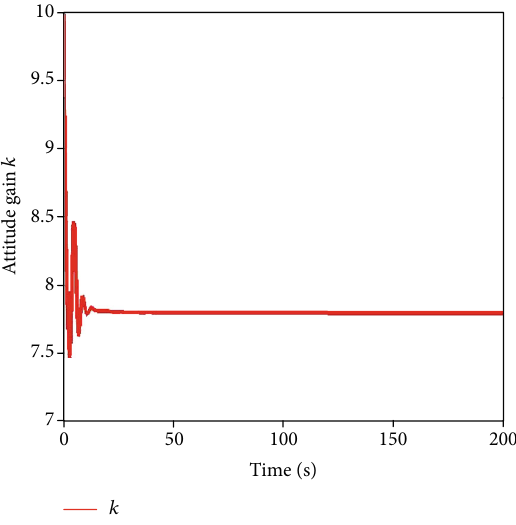
Figure 26: Time histories of attitude gain k in Case 3 when k ð 0 Þ = 10 .